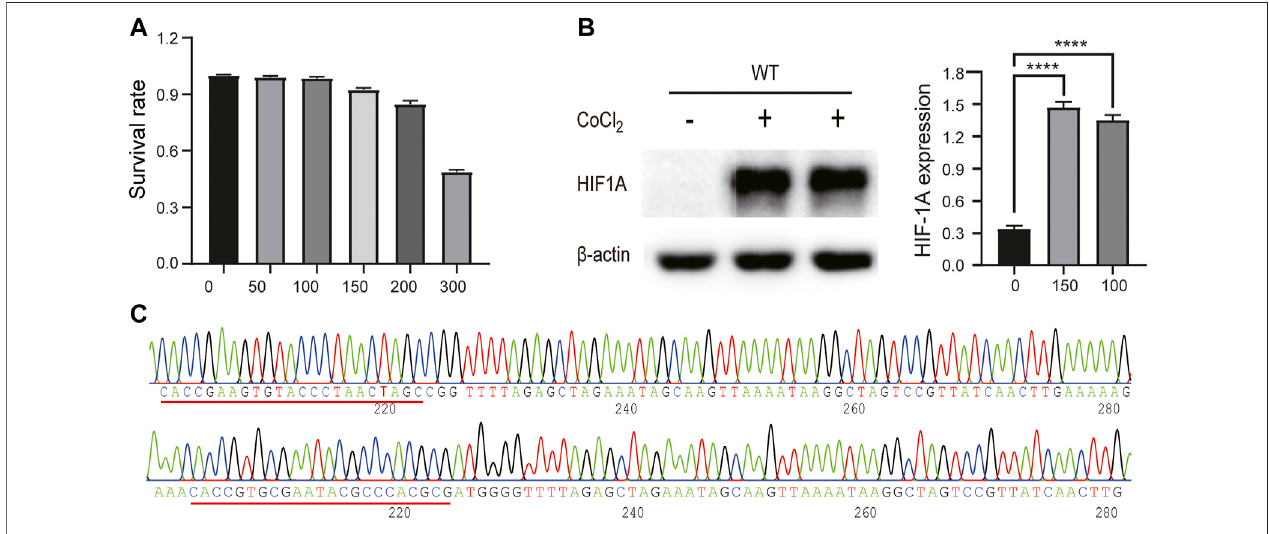
FIGURE 1 | CoCl 2 -induced conditions and plasmid construct. (A) Cytotoxicity of CoCl 2 to HepG2 cells was measured by MTT assay. (B) Comparison of HIF1A protein expression between control cells and CoCl 2 -treated cells (**** p < 0.0001). (C) Sequencing results of 52961V2